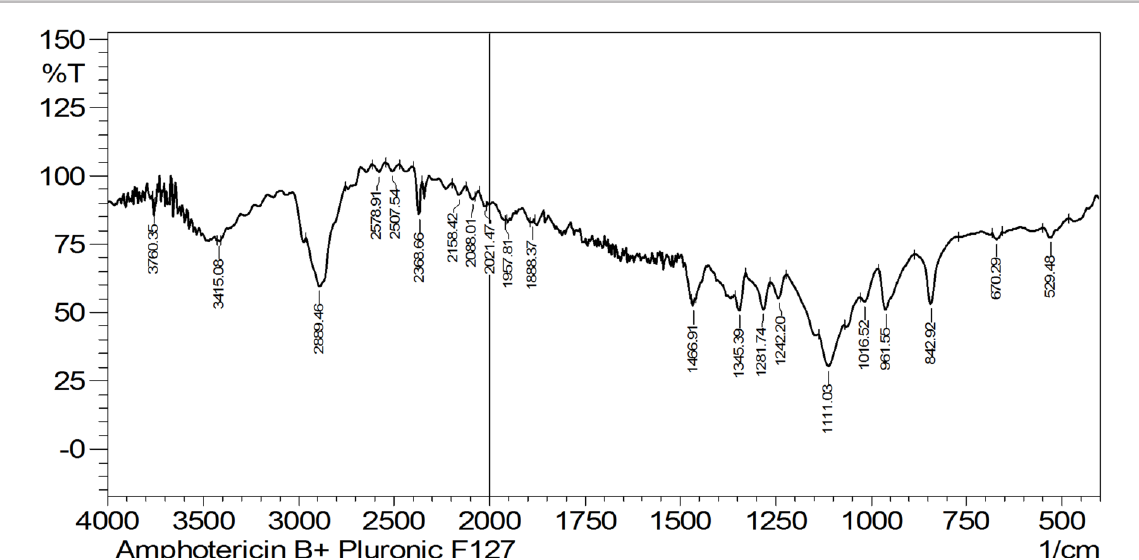
FIGURE 5 - FTIR spectrum of optimized formulation